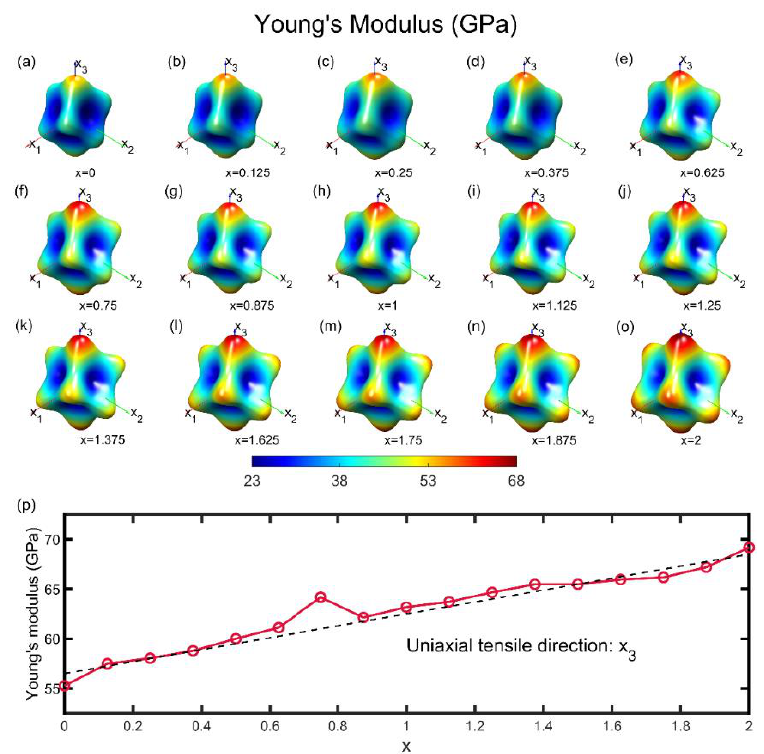
Figure 3. The 3D Young’s modulus distribution at various Sb contents. ( a – o ) Direction-dependent Young’s modulus for every potency of Sb at an interval of 0.125, ranging from 0 to 2. ( p ) Young’s modulus along the uniaxial tensile direction of x 3 as a function of the Sb content x. A linear dependency can be viewed (dashed line).